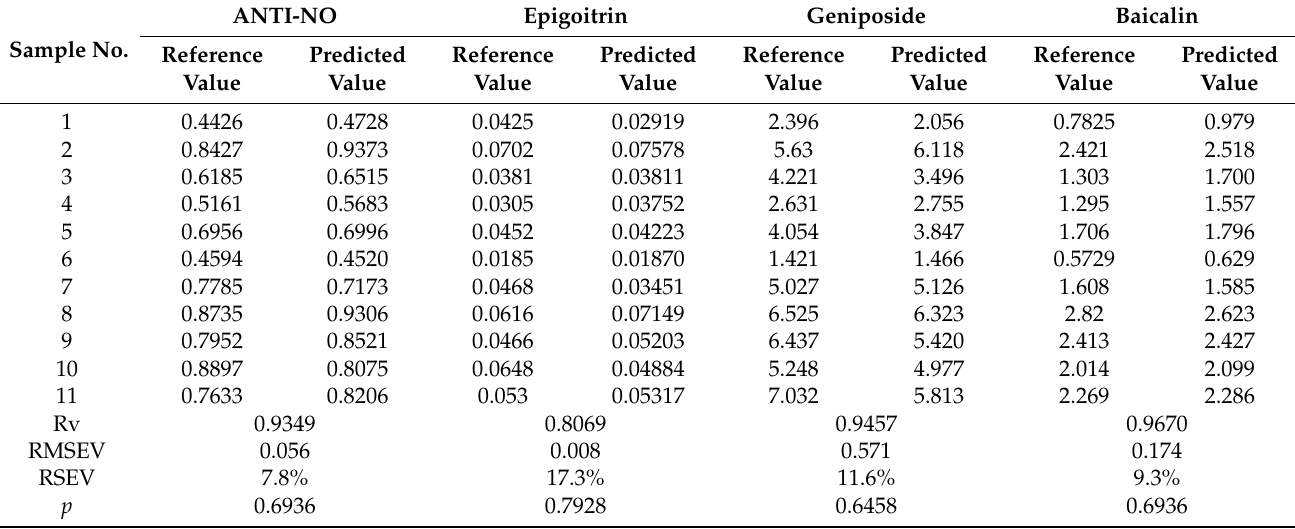
Table 4. The results of external validation of traditional